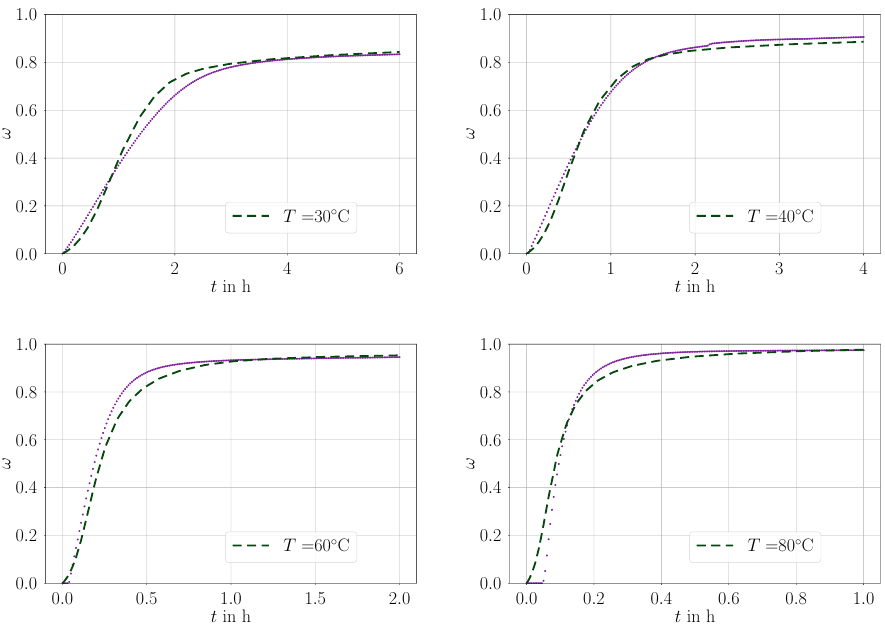
Figure 4. Comparison of the parameter fit (dashed line) with all experimental values (dots) used for the fit, material: material B.